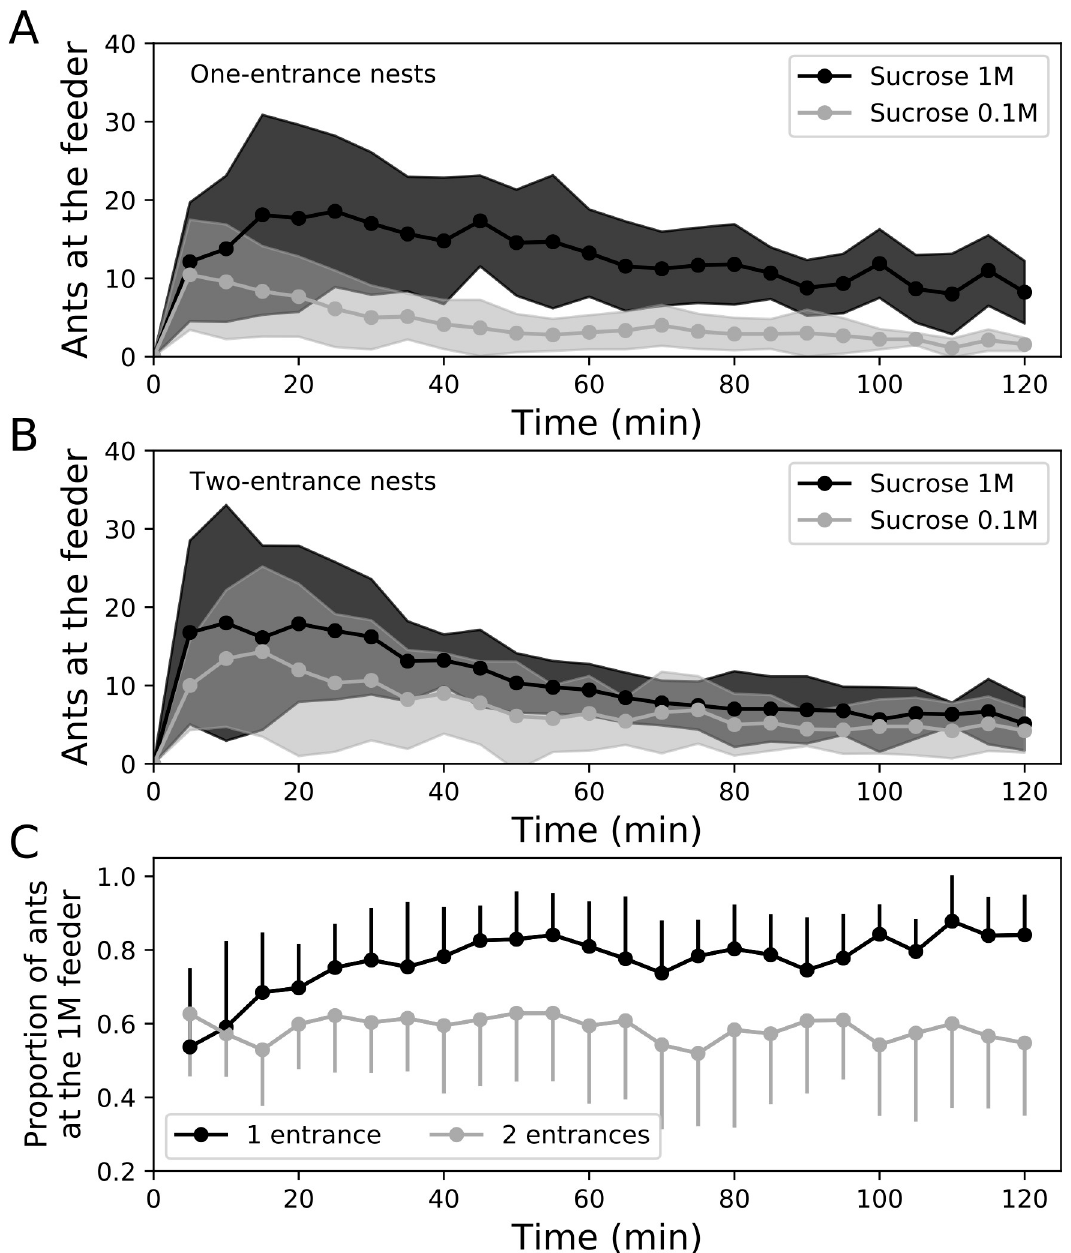
Fig 6. Relative exploitation of feeders over time. Number of ants at the 0.1M or the 1M feeder for (A) one-entrance nests, and (B) two-entrance nests as a function of time. Proportion of ant present at the richest feeder in both nest entrance configurations (C). In each experiment, one feeder was filled with 1M sucrose solutions (black circles, dark grey shading) and the other feeder with 0.1M sucrose solution (light grey circle, light grey shading). Circles and shadings represent the mean ± standard deviation, respectively. one-entrance nest condition (Fig 6C). For the two-entrance nest condition, the population of foragers at the food source changed over time but in a similar way at each feeder, regardless of its sugar concentration (Fig 6B: Two-way ANOVA for repeated measures, time effect: F = 24,400 13.46, p < 0.001, food quality effect: F = 2.11, p = 0.17, interaction effect: F = 0.79, 1,400 24,400 p = 0.75). In accordance with the former results of individual tracking, the proportion of